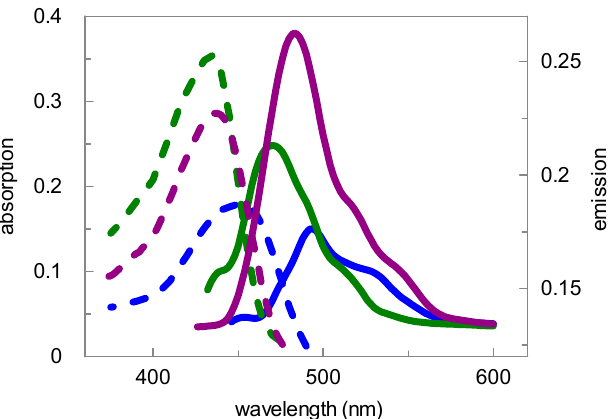
Figure 2. Absorption (10 μ M, 1% DMSO, dashed lines) and emission (1 μ M, 1% DMSO, solid lines) spectra of the ebselen-coumarin heterodimer 15 . The extinction and the fluorescence units, respectively, were plotted versus the wavelength. Spectra recorded in buffer (50 mM sodium phosphate, pH 7.8, with 500 mM NaCl) ( blue ), MeOH ( violet ) and CH 2 Cl 2 ( green ) are shown. Wavelengths of absorption were used for excitation. The heterodimer 9 was measured similarly (see Table 1). All fluorescent measurements were carried out with a PMT value of 200 V. Table 1. Absorption and emission maxima of compounds 9 and 15 . Compd.